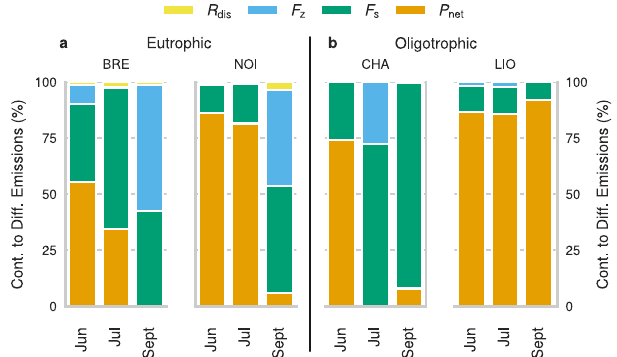
Fig. 4 | Contribution to diffusive atmospheric CH 4 emissions from each com- ponentoftheCH 4 budget. Thesediment fl ux( F s ),diffusive fl uxfromhypolimnion ( F z ), bubble dissolution ( R dis ), and net production rates ( P net ) in the SML of Lac de Bretaye (BRE), Lac Noir (NOI), Lac des Chavonnes (CHA) and Lac Lioson (LIO). The lakesweredividedas a eutrophicand b oligotrophiclakes.Theresultsfromthefull- scale mass balance were used as representative P net rates of the studied